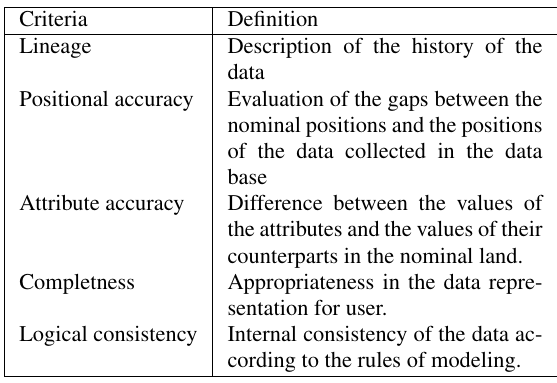
Table 1: Evaluation criteria of data